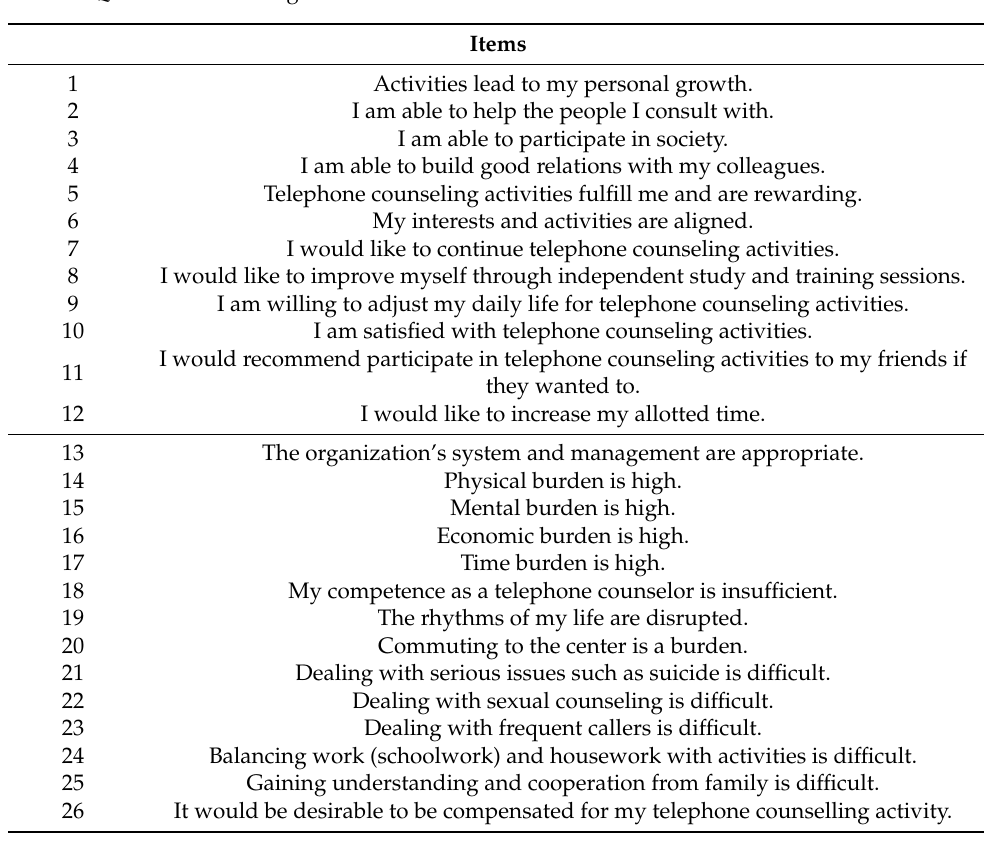
Table 1. Questions on “thoughts on